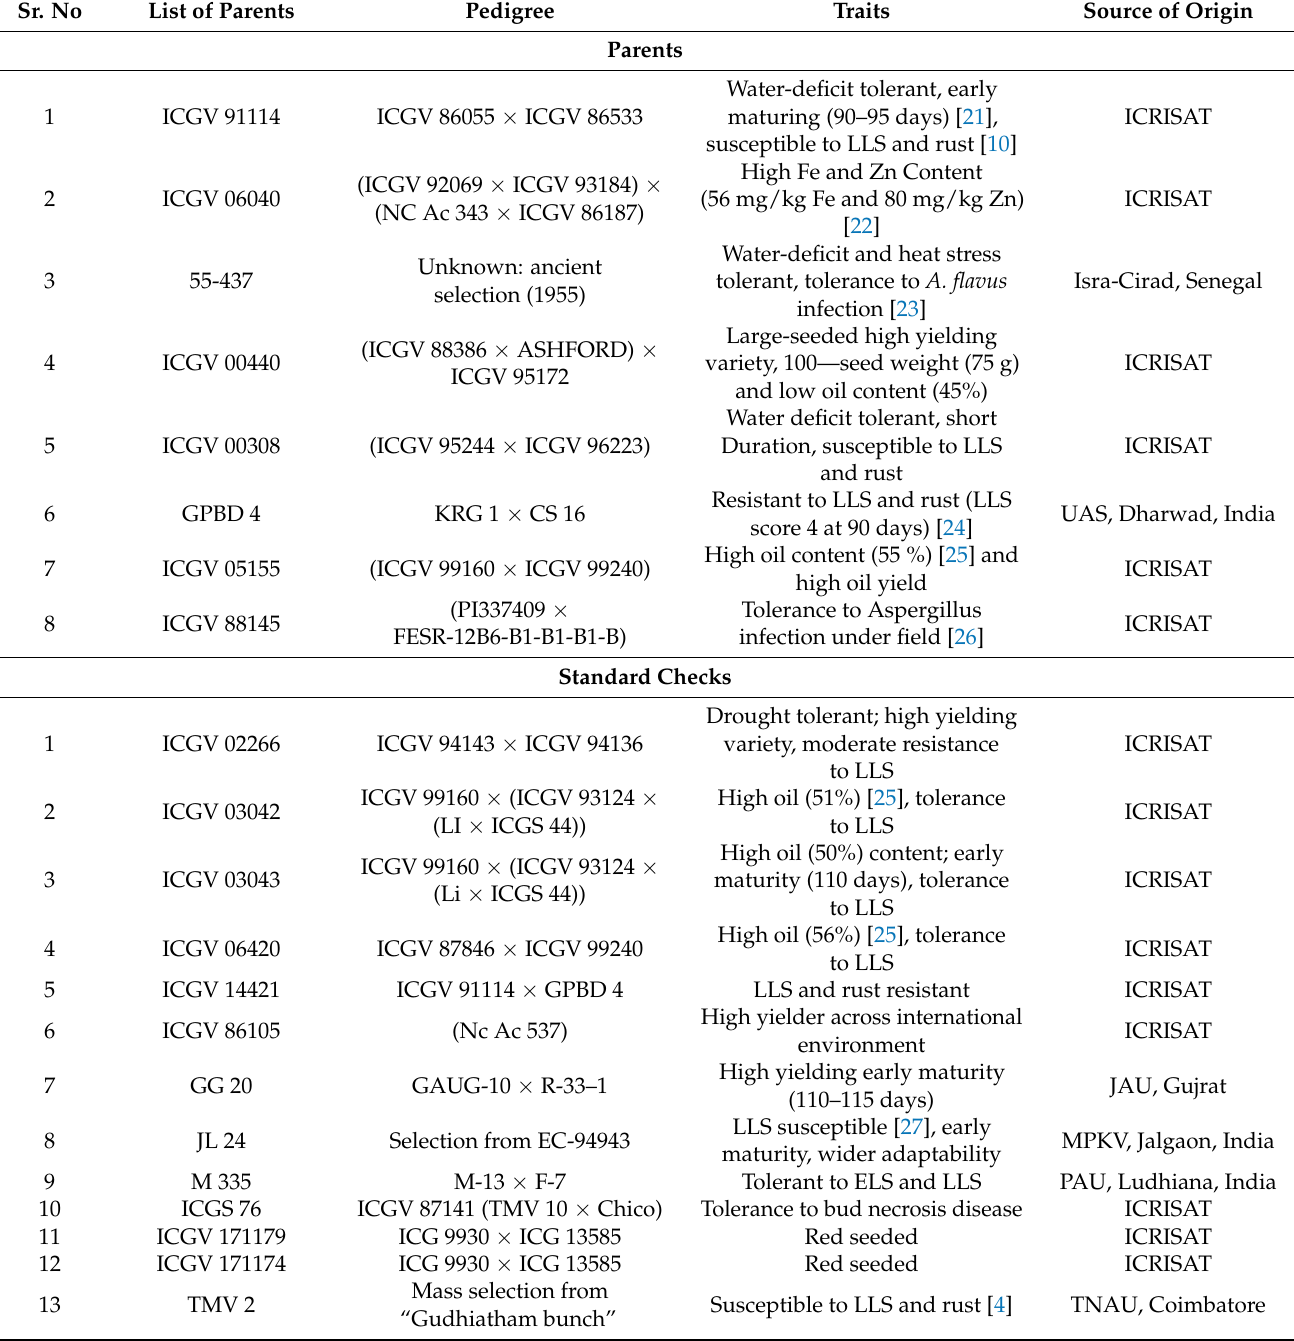
Table 1. List of founder parents used in the development of MAGIC population and standard checks. Sr.